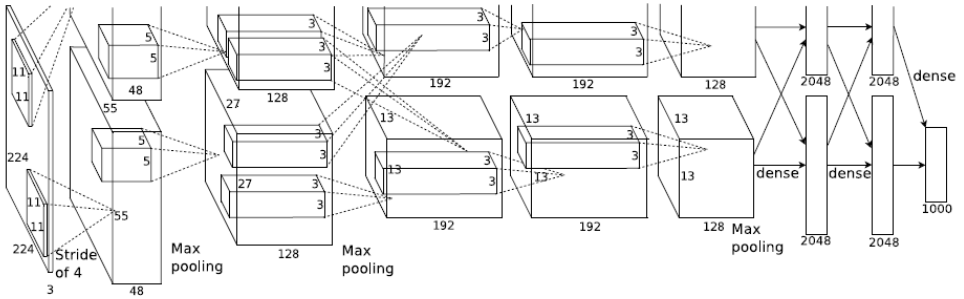
Figure 1. The original AlexNet structure (extracted from [32]).